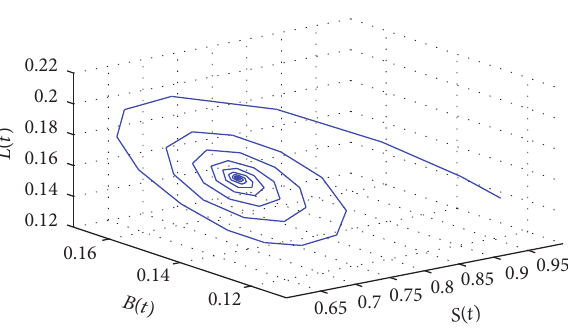
Figure 2: The phase plot of the states 𝑆 ∗ , 𝐿 ∗ , and 𝐵 ∗ when 𝜏 = 0.92,0.155, 0.112 18.3656 < 𝜏 0 with initial value “